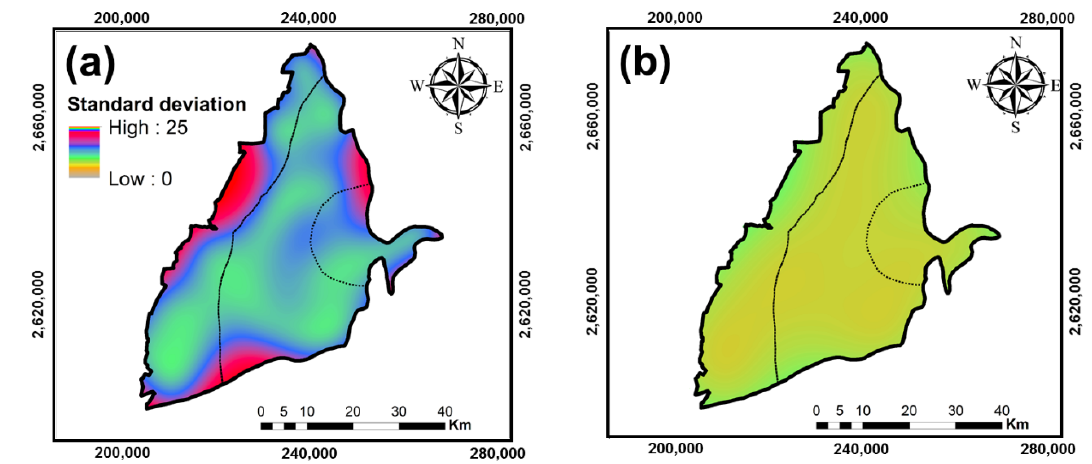
Figure 5. An example of comparing the kriging error variance for different methods: ( a ) kriging standard deviation of GWL using Ordinary Kriging (OK) for January 2006; ( b ) the kriging standard deviation of GWL using Regression Kriging (RK) for January 2006.